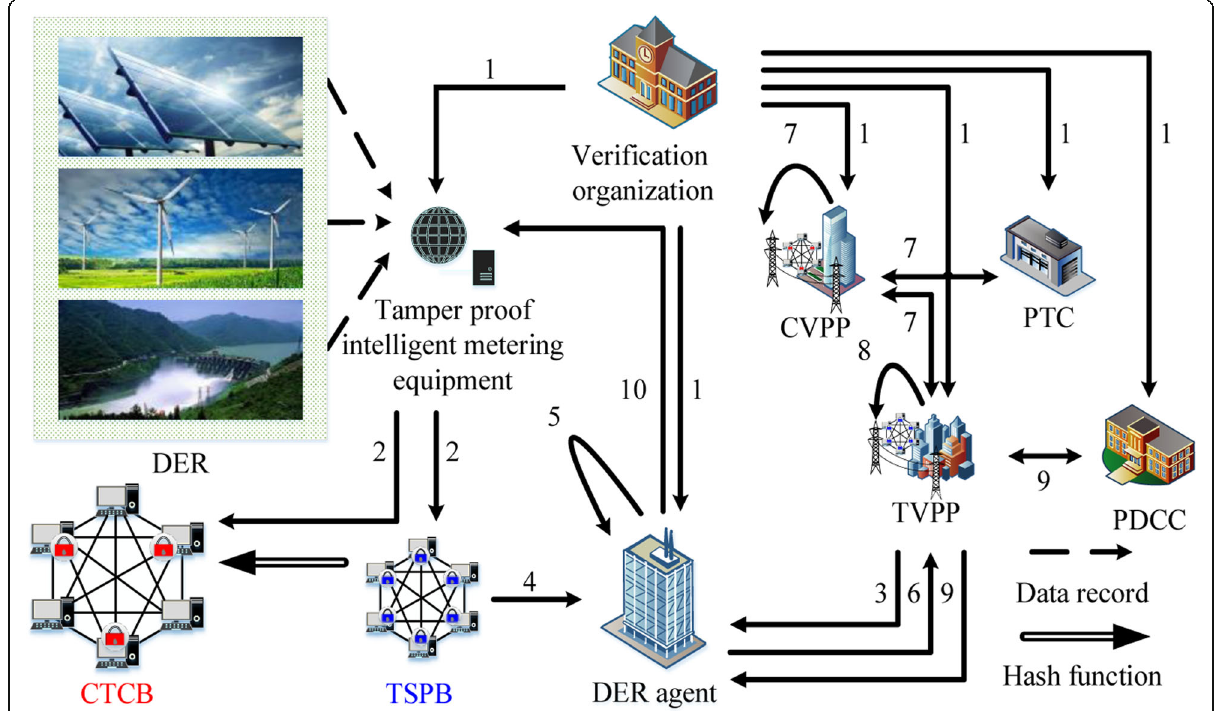
Fig. 5 VPP security scheduling model based on dual